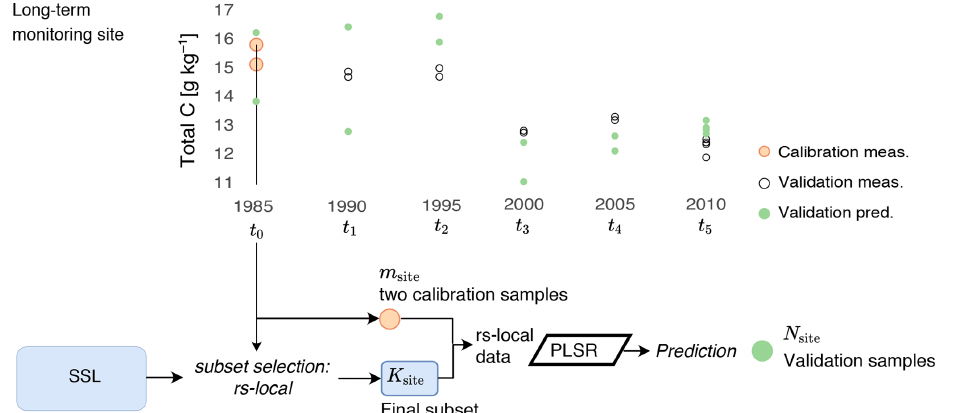
Figure 2. Conceptual scheme illustrating the transfer of the soil spectral library (SSL) to a long-term monitoring site using the RS-LOCAL approach. The local calibration samples and a subset of the SSL are used to calibrate a partial least squares regression (PLSR) model, which predicts the local validation